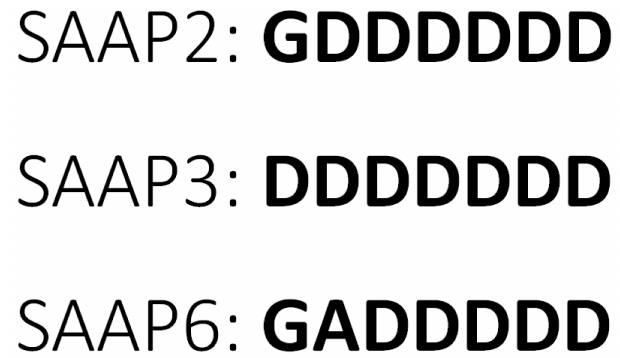
Figure 1. Amino acid sequences of SAAP2, SAAP3, and SAAP6